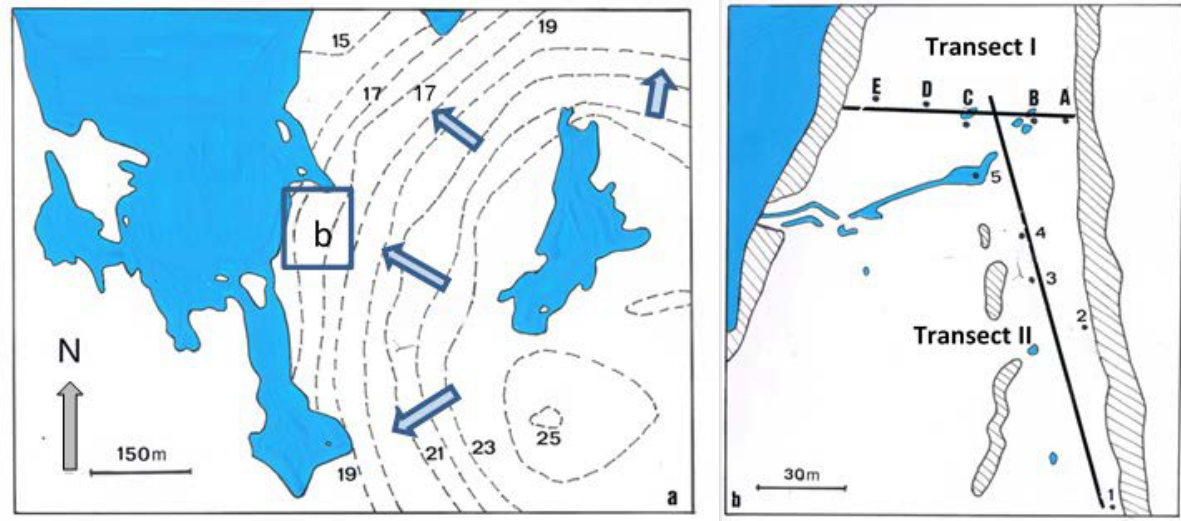
Figure 2. (a) Height map (derived from Google Earth) showing contour lines (m above sea level) and the inferred direction of (sub)surface water flows. (b) Position of the study area with sample points within two (crossing) transects. Open water (blue) and rock outcrops (shaded) are also indicated.